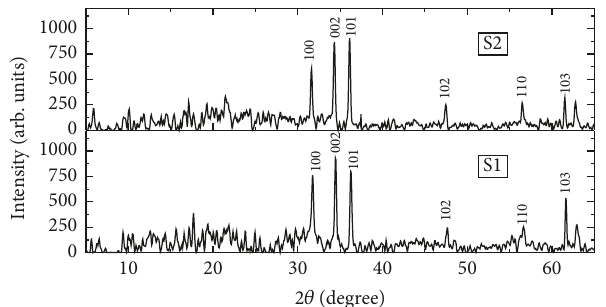
Figure 1: X-ray diffraction (XRD) patterns obtained for ZnO thin films S1 and